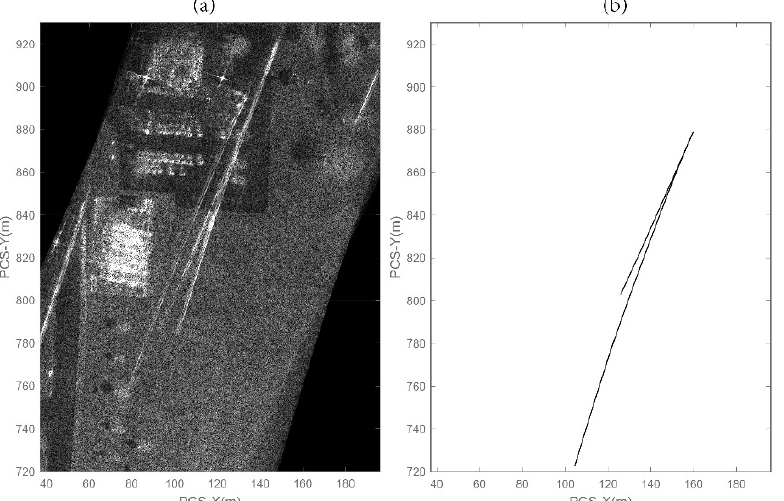
Figure 22. Small scene 1 experiment. The azimuth time interval is 37.1–47.2 s, and the corresponding target’s real trace is from point E to point F in Figure 21. ( a ) is the SAR image, and ( b ) is the corresponding estimated image